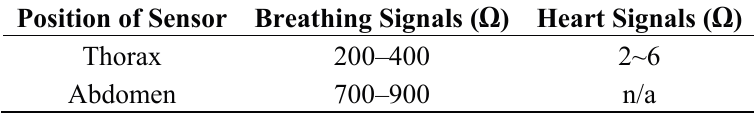
Table 3. Strength of cardio respiration